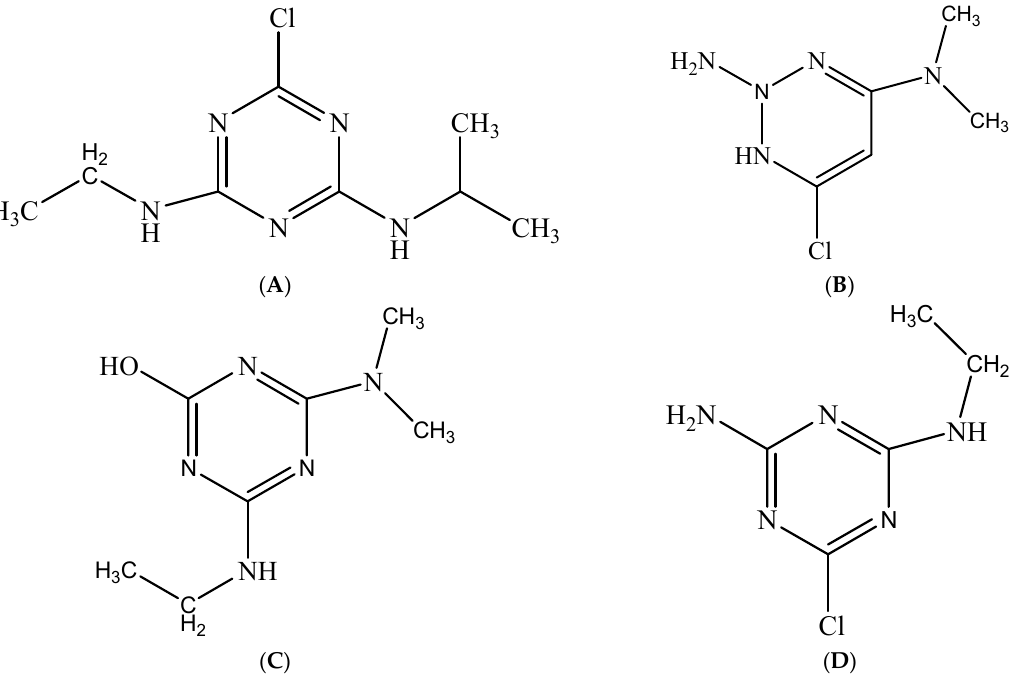
Figure 1. The chemical structure of atrazine and its metabolites: ( A ) atrazine (ATZ); ( B ) Desethylatrazine (DEA); ( C ) Hydroxyatrazine (HYA); ( D ) Desisopropylatrazine (DIA). The contamination of ATZ and its metabolites to aquatic environments is also an issue of popular concern because of their high persistence and mobility. Liu et al. reported that ATZ and its chlorometabolites had toxic effects on zebrafish because of the high concen- trations of ATZ in surface water (even more than 300 µ g/L) [11].